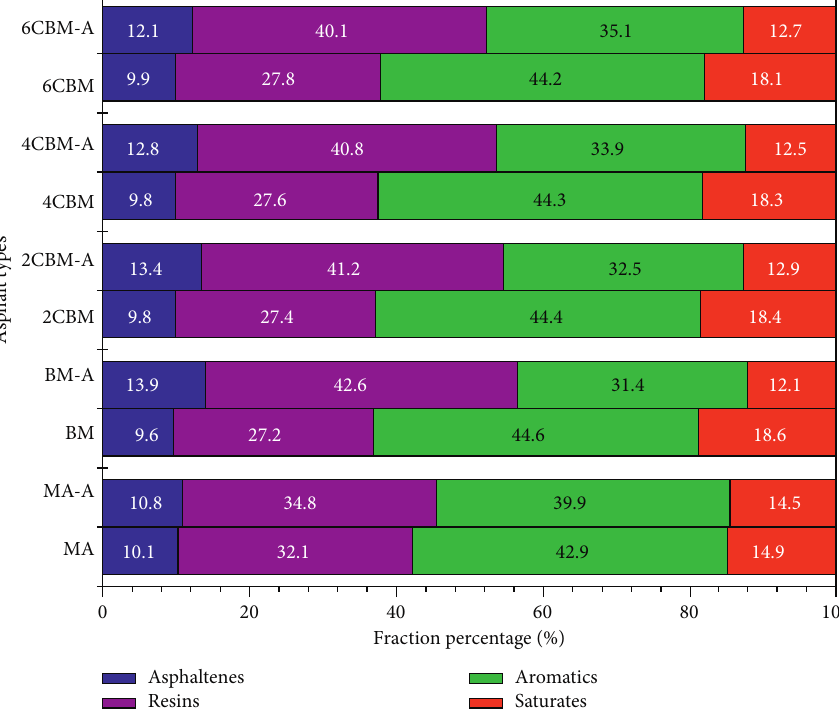
Figure 7: Effect of organic nano-CaCO 3 on components of bioasphalt before and after